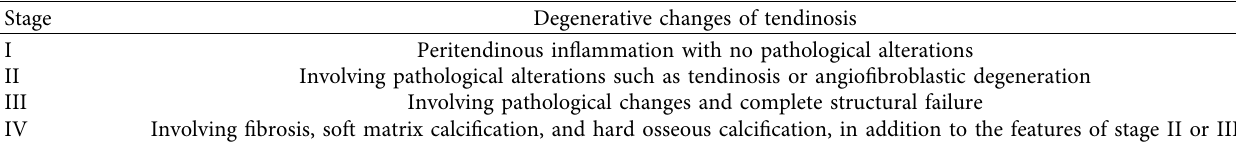
Table 1: Pathologic stages of lateral epicondylitis.